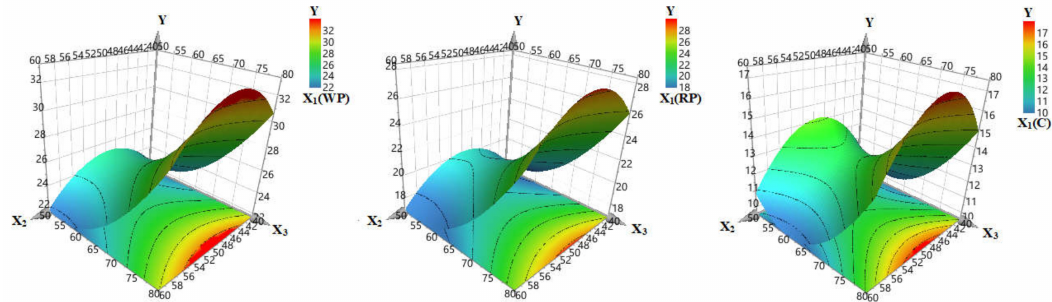
Figure 3. Response surfaces describing the total polyphenols content (Y) as a function of ethanol ratio (X 2 ) and temperature (X 3 ), for the three types of plant material (X 1 ): white pomace (WP), red pomace (RP) and canes